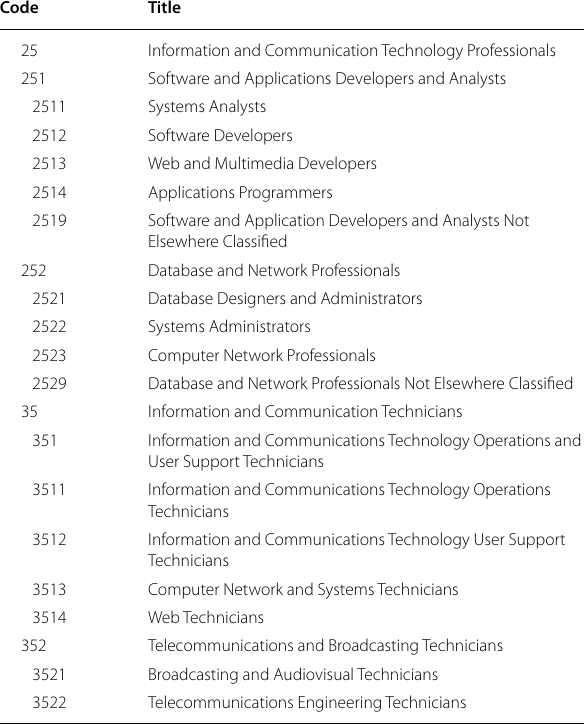
Table 1 ICT occupations according to ISCO-08